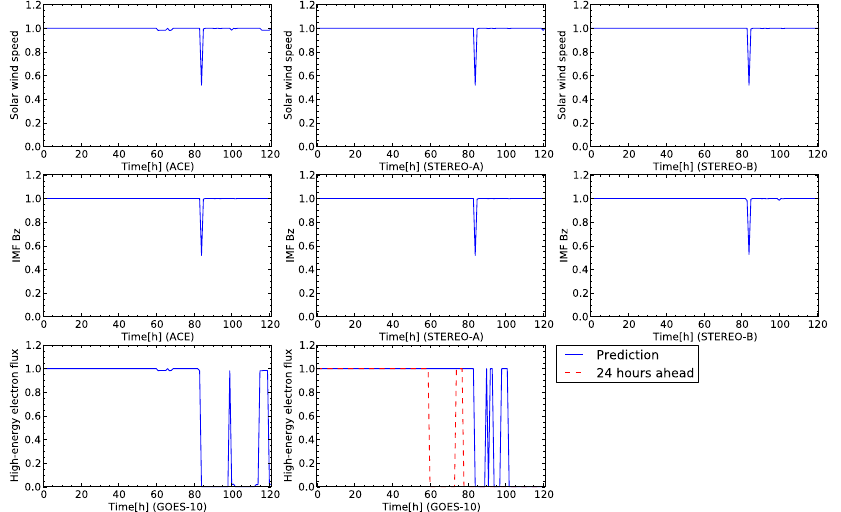
Figure 8. Time development of credibility for the data shown in Figure 4. The eight-sensor model evaluates the test data. The value on a vertical axis represents a credibility corresponding to a sensor name indicated on the vertical axis. The name of the satellite for the sensor is represented at horizontal axis. In the first and second rows, the plots of the columns correspond to the sensors on ACE, STEREO-A, and STEREO-B, respectively. In the third row, the left-most and right-most plots correspond, respectively, to GOES-10 and GOES-10 24 h